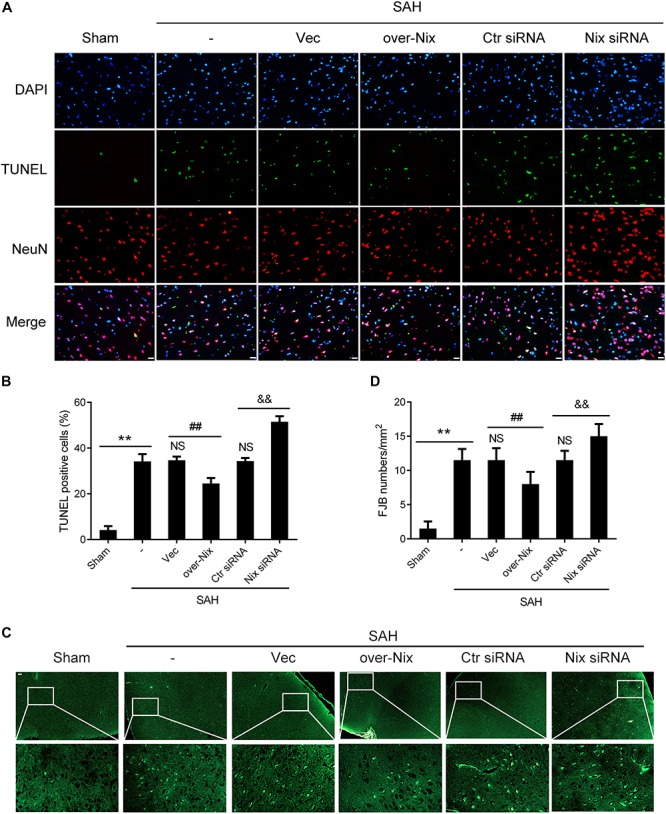
Effects of Nix on the neuronal apoptosis and degeneration at 24 h after SAH. (A,B) TUNEL staining showed apoptotic cells in the Sham, SAH, SAH + Vec, SAH + over-Nix, SAH + Ctr siRNA, and SAH + Nix siRNA groups. Double-immunofluorescent staining was performed with TUNEL (green) and a neuronal marker (NeuN, red), and nuclei were fluorescently labeled with DAPI (blue), Scale bar = 20 μm; **p < 0.01 vs. Sham group; NSp > 0.05 vs. SAH group; ##p < 0.01 vs. SAH + Vec group; &&p < 0.01 vs. SAH + Ctr siRNA group; n = 6. (C,D) FJB fluorescence staining (green) showing neuronal degeneration. Scale bar = 20 μm. **p < 0.01 vs. Sham group; NSp > 0.05 vs. SAH group; ##p < 0.01 vs. SAH + Vec group; &&p < 0.01 vs. SAH + Ctr siRNA group; n = 6.